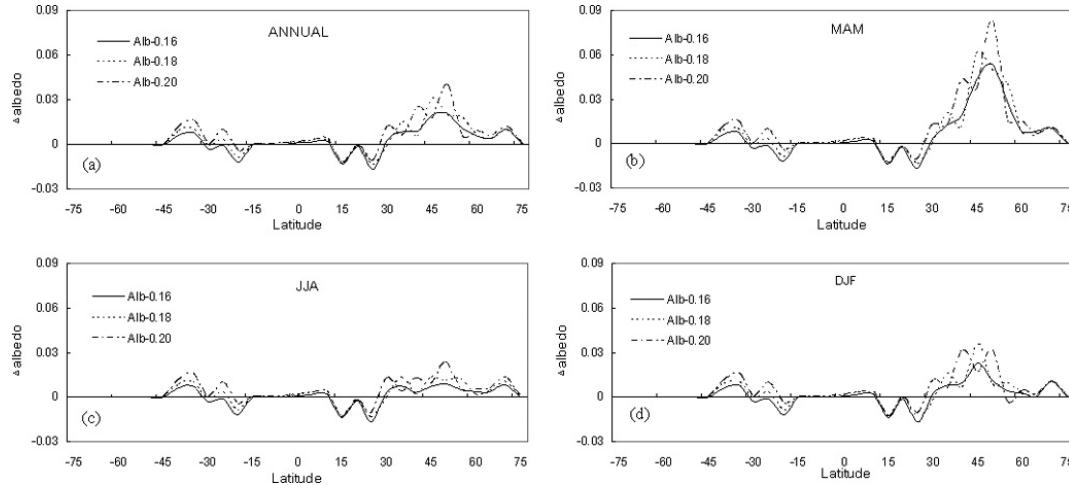
Fig. 5. Zonally averaged changes in surface albedo for different seasons, (a) annual; (b) MAM (March–May); (c) JJA (June–August); (d) DJF (December–February), for simulation